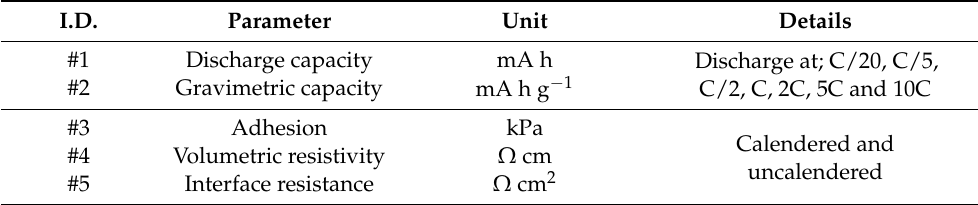
Table 2. Outputs used in single-variable and multi-variable